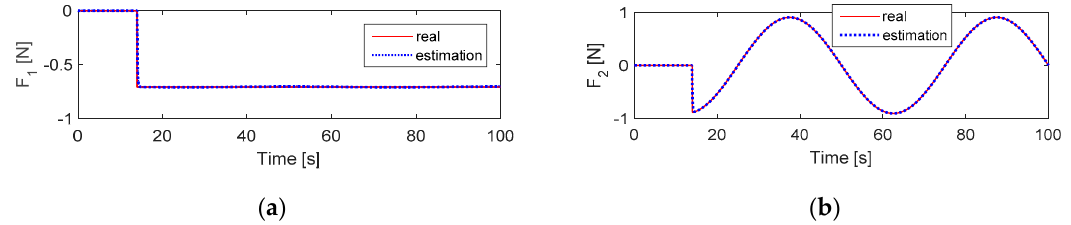
F fault offset and ( b ) F fault offset. 1 2